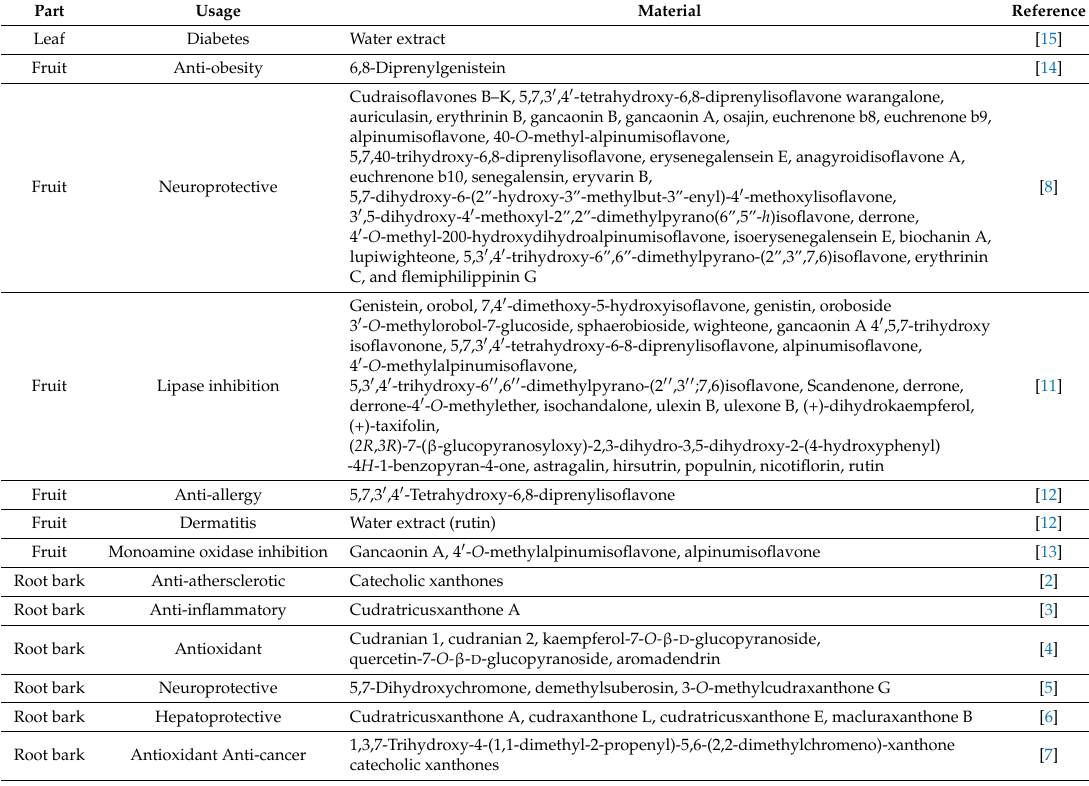
Table 1. Medicinal activity and composition of C. tricuspidata